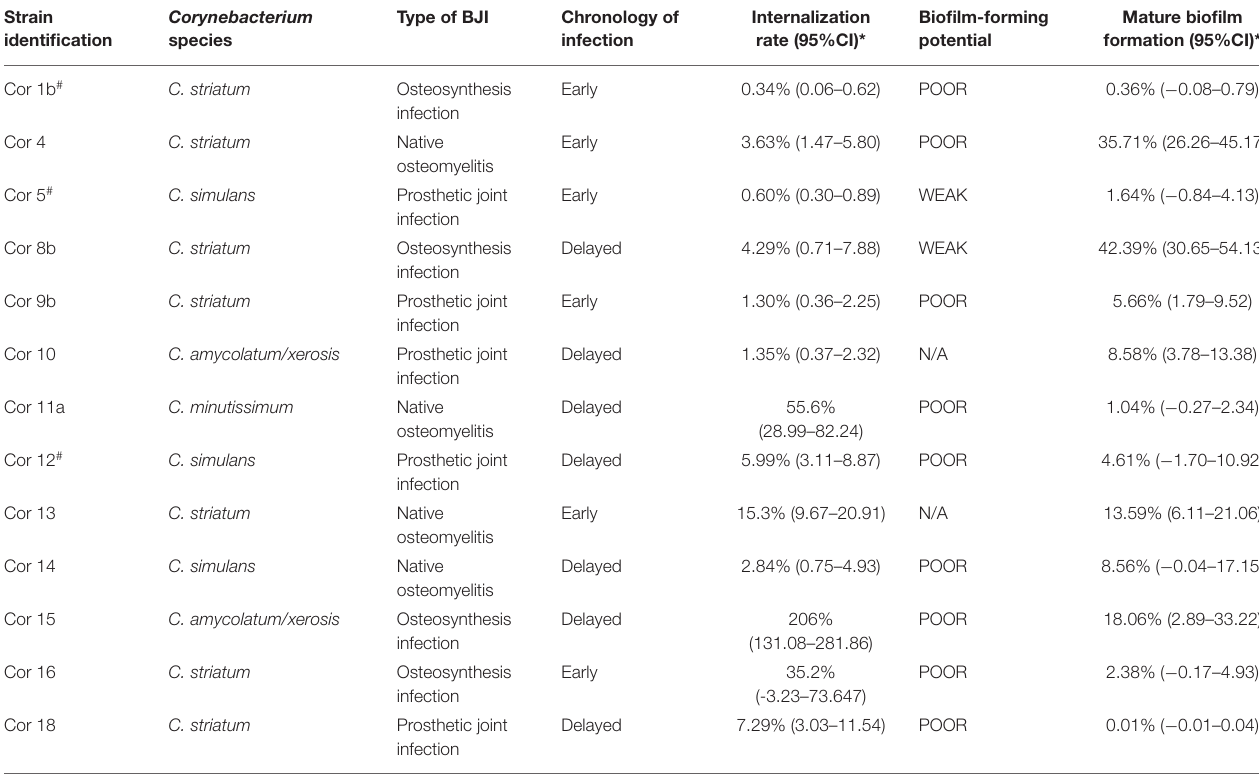
TABLE 3 | Description of the isolates evaluated in the osteoblastic cell infection model and biofilm formation assays. Strain identification